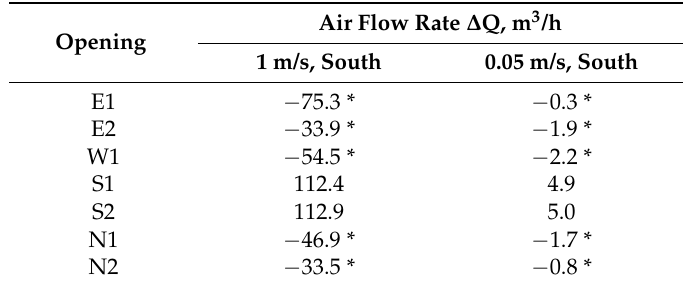
Table 1. The result of the Airflow rate through the underfloor